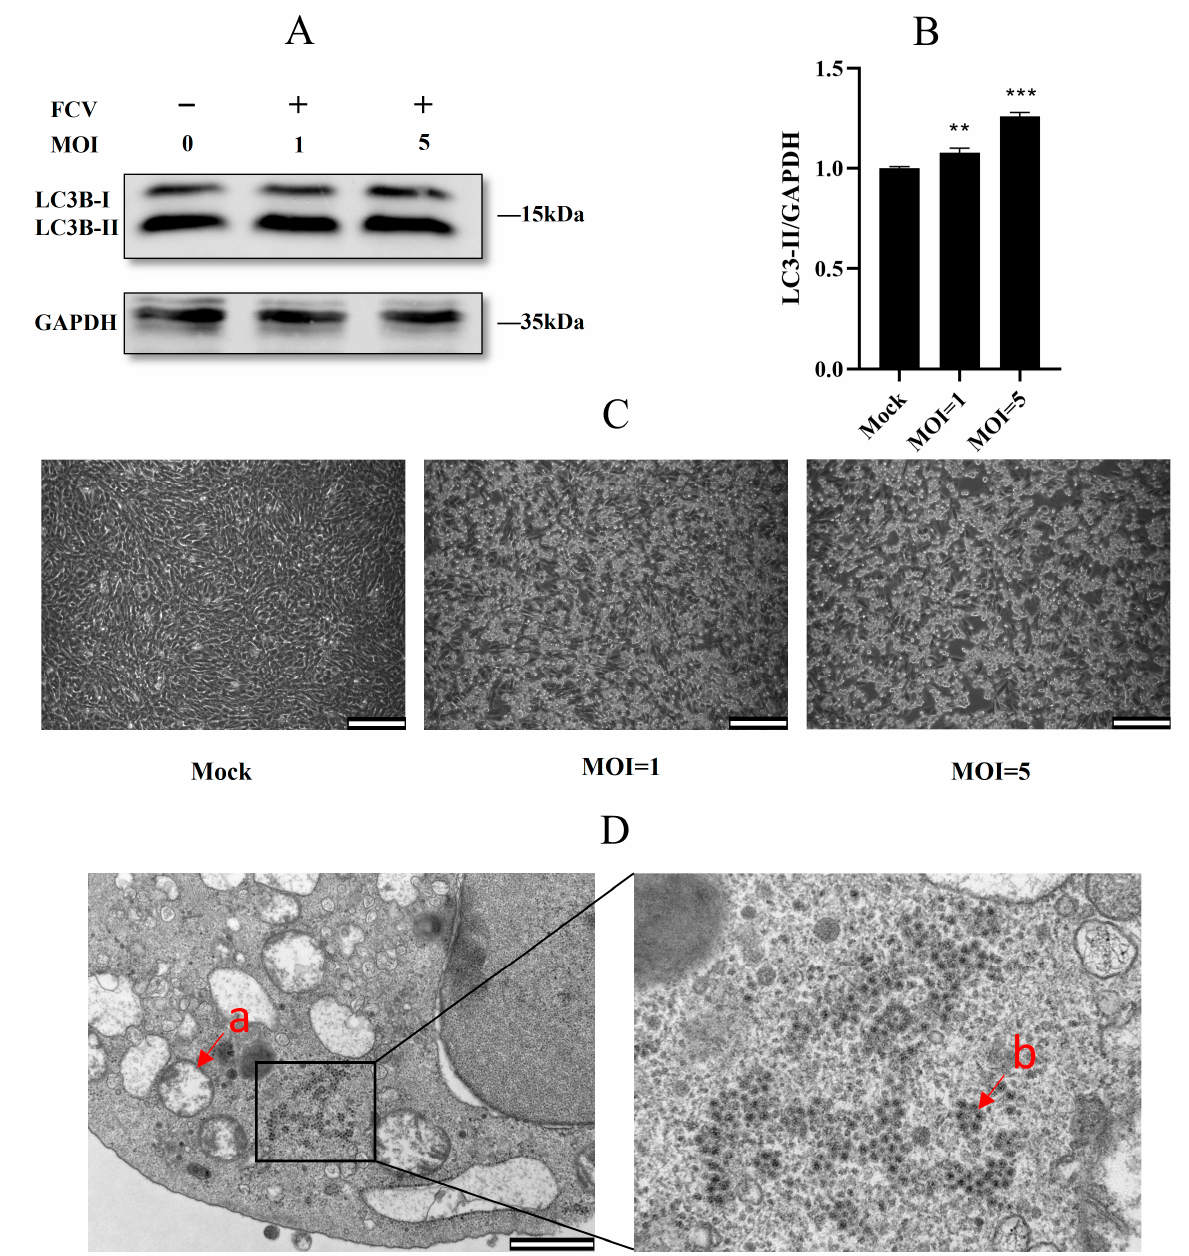
Figure 1. Feline calicivirus infection-induced autophagy. ( A ) With the increase in MOI, the expres- sion of LC3-II was correspondingly increased. ( B ) Protein band intensity of LC3B-II and GAPDH. ( C ) A higher infection of MOI indicated more evident CPE. ( D ) CRFK cells were infected with FCV and fixed for resin embedding at 12 h.p.i. Double membrane vesicles can be observed in the cytoplasm of cells infected with FCV. The double membrane vesicles are identified with a, and FCV virions with b. Scale bar 1 um. (** p < 0.01, *** p < 0.001).